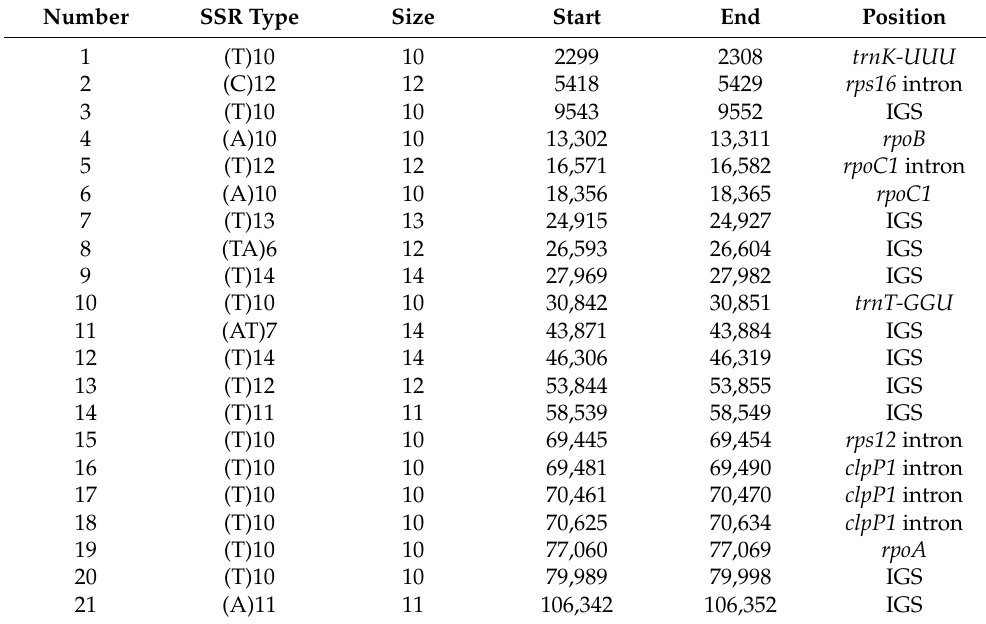
Table 3. Distribution of SSRs within E. fortunei chloroplast